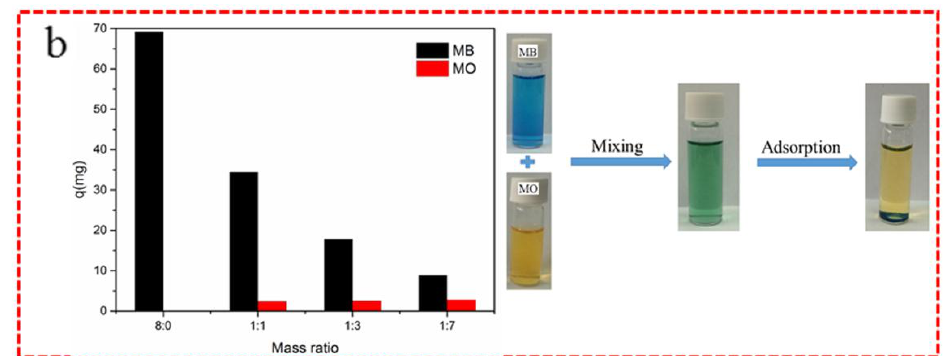
Figure 5. Simultaneous adsorption of two cationic dyes (malachite green (MG) and rhodamine B (RhB)) with the same concentration (10.0 mg/L) at different mass ratios ( left ) and their photographs at same ratio ( right ) ( a ), and simultaneous adsorption of one cationic dye (methylene blue (MB)) and one anionic dye (methyl orange (MO)) with the same concentration (10.0 mg/L) at different mass ratios ( left ) and their photographs at same ratios ( right ) ( b ).